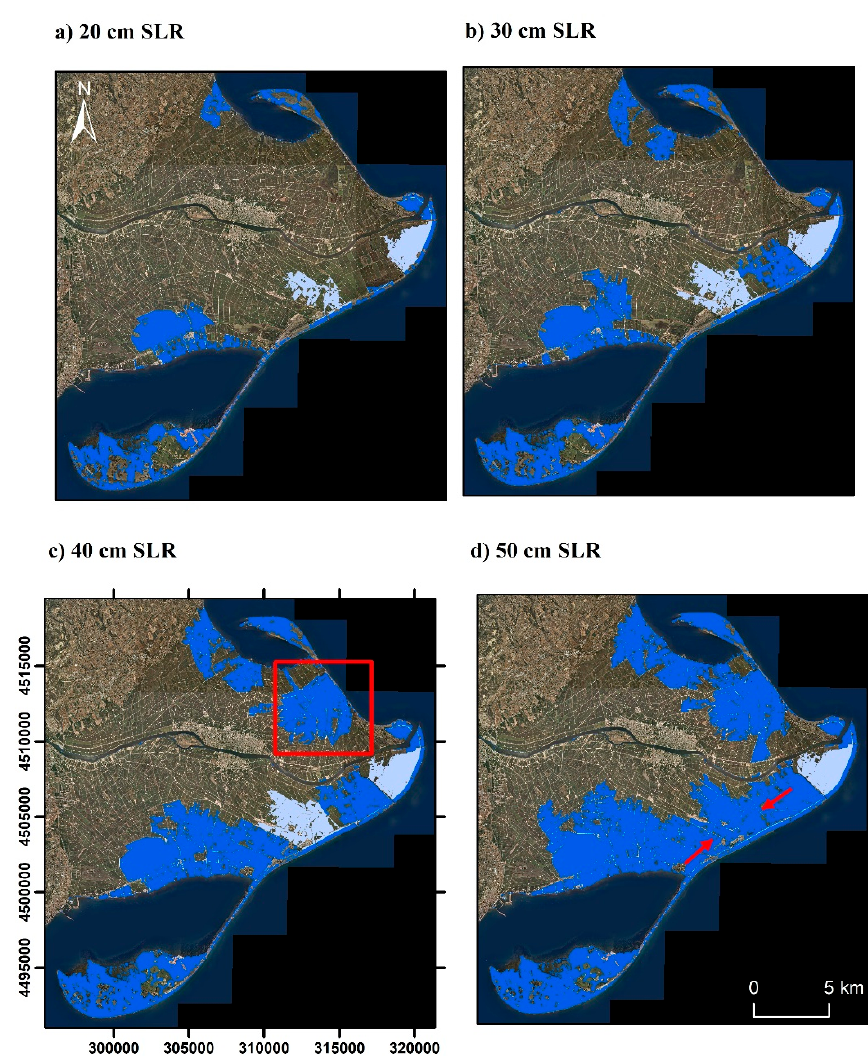
Figure 6. Inundation-prone areas in the ED under different RSLR scenarios: ( a ) 20 cm; ( b ) 30 cm; ( c ) 40 cm; and ( d ) 50 cm. Light-blue shading indicates additional areas of inundation not accounting for dynamic beach response (i.e., computed using the static bathtub approach but not the pseudo-dynamic method). Active beach adaptation to RSLR is prevented when accommodation space is insufficient (e.g., the red square in ( c ) where narrow beaches are backed by infrastructure). Due to the network of channels crisscrossing the plain, some areas otherwise protected by a beach can be inundated by water from adjoining areas (red arrows in ( d )). (The geographic coordinate system is ETRS89/UTM zone 31N).